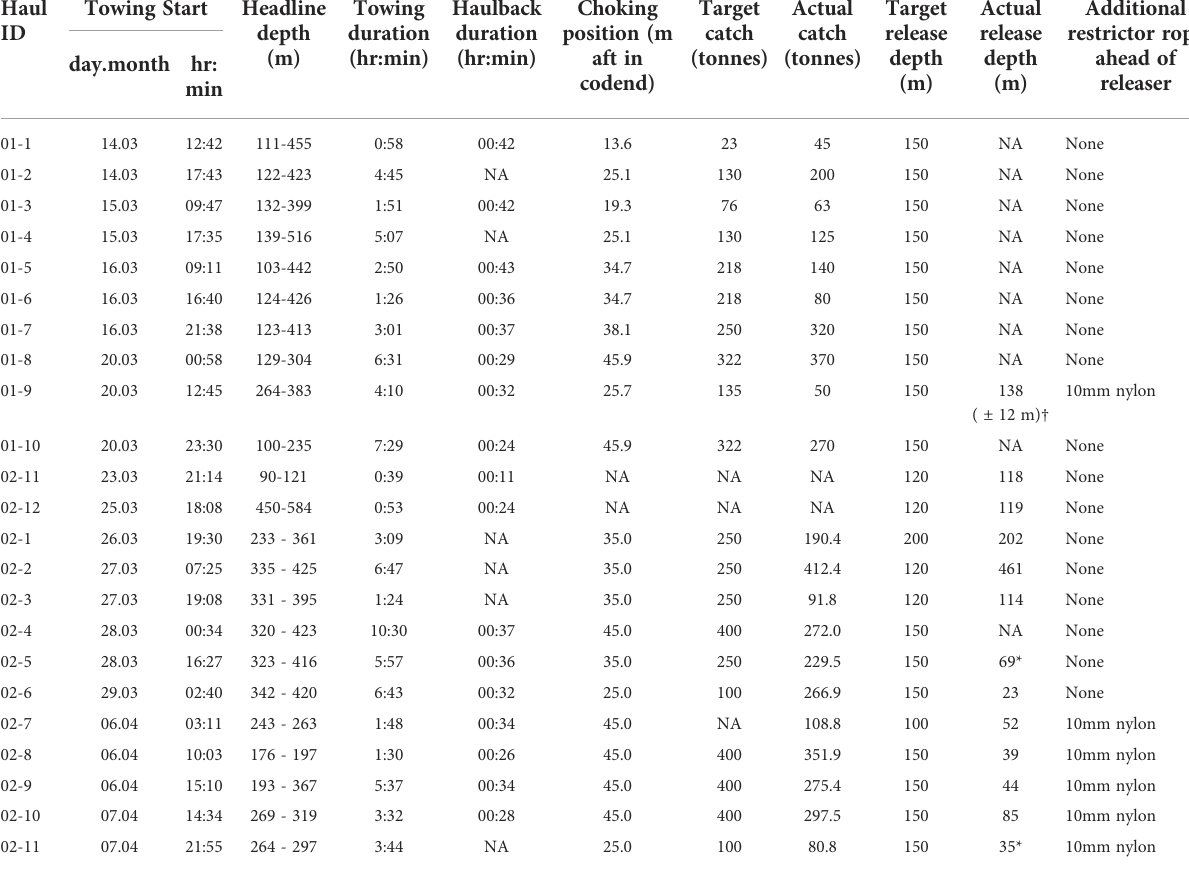
TABLE 2 Haul summary, including details of towing times and duration, haulback duration, release opening design, codend choking unit position and release depths and both target and actual catch